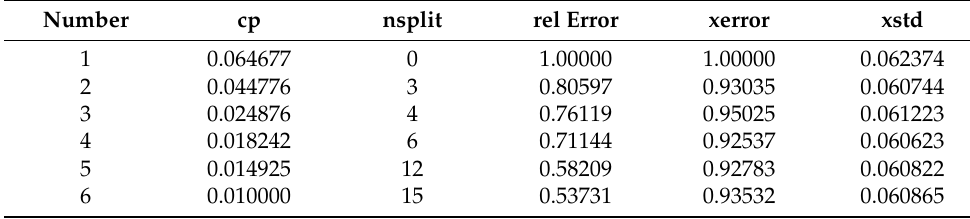
Table 8. Decision tree model performance (cp = 0.01).